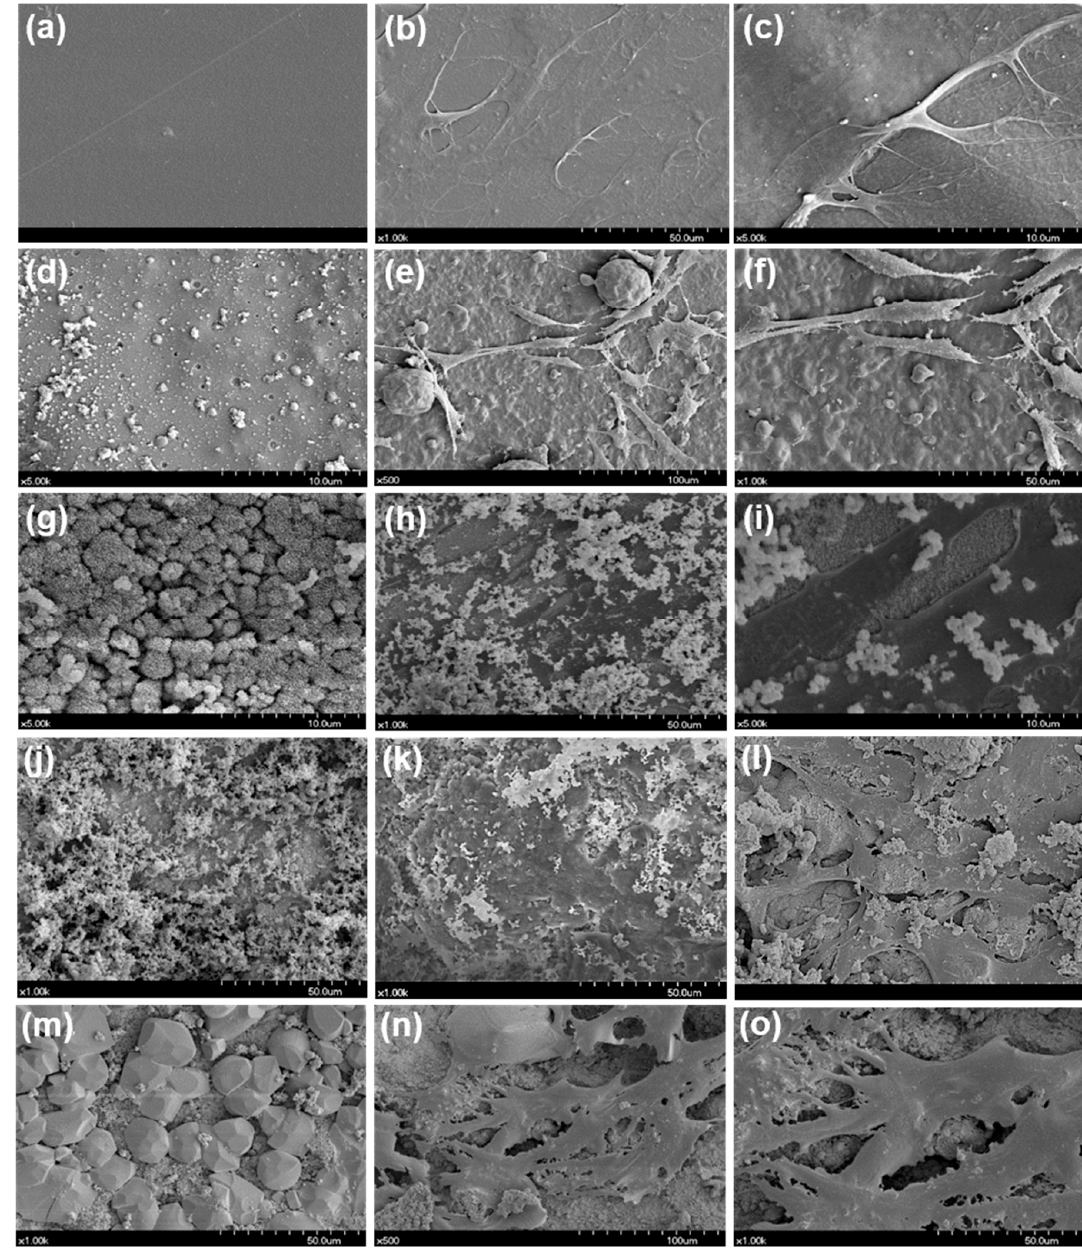
Figure 5. Scanning electron microscope (SEM) results of direct contact of human dental pulp stem cells (hDPSCs) with each experimental sealer. ( a ) Control group, ( b,c ) cells with control disk, ( d ) AH Plus disk, ( e,f ) cells with AH Plus disk, ( g ) EndoSequence BC Sealer disk, ( h,i ) cells with EndoSequence BC Sealer disk, ( j ) BioRoot RCS disk, ( k,l ) cells with BioRoot RCS disk, ( m ) Endoseal MTA disk, ( n,o ) cells with Endoseal MTA disk. In the Alizarin red staining assay, hDPSCs exposed to EndoSequence BC, BioRoot RCS, and Endoseal MTA extracts showed a significant increase in calcium nodule formation compared to the AH Plus group at 15 days ( p < 0.05) (Figure 6).